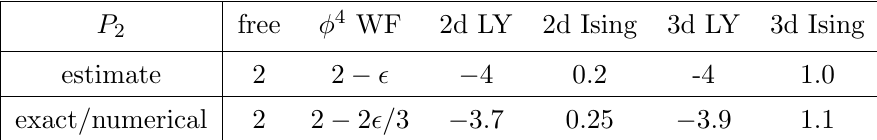
Table 1 . The estimates of the OPE coe(cid:14)cient P 2 from (2.59) and the known results from exact solutions [96, 104] or numerical conformal bootstrap [53, 77] in several CFTs. We only show two signi(cid:12)cant (cid:12)gures. Input parameters are the scaling dimensions of (cid:30) 1 ; (cid:30) 2 from the exact results [96, 104] or numerical conformal bootstrap [53, 77]. LY and WF stand for Lee-Yang and Wilson-Fisher. To derive the estimates of P 2 in the Lee-Yang CFTs, we only use the information that (cid:1) 1 = (cid:1) 2 and the analytic estimate is P 2 = (cid:0) 4. The relative errors in 3d interacting CFTs are smaller than those in